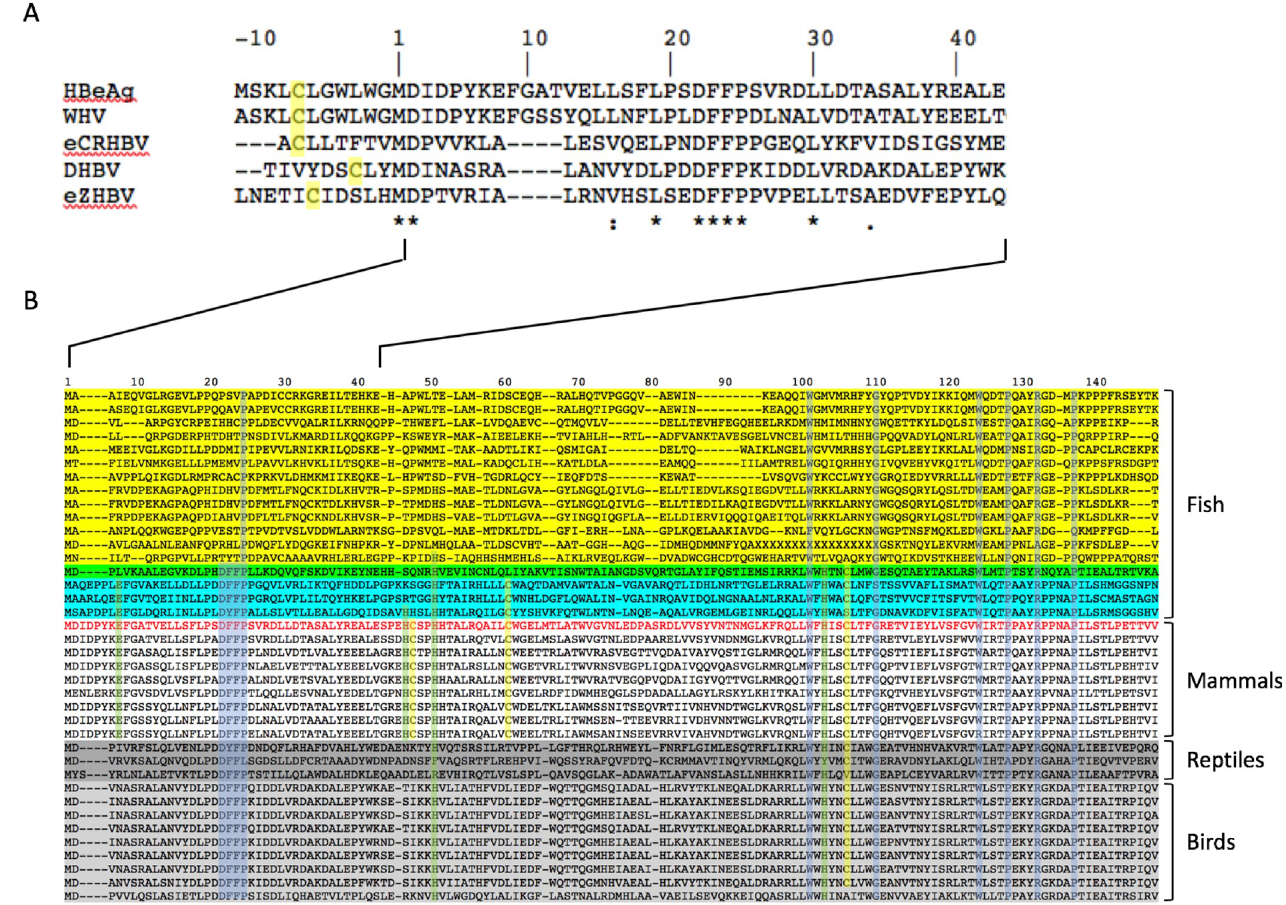
Fig 9. Multiple sequence alignment of core-antigen related proteins. (A) PreC/C ORF sequences. Shown are sequences for human (HBeAg), woodchuck (WHV), and duck (DHBV) viruses, and for zebra finch (eZHBV) and crocodile (eCRHBV) endogenized viral elements. For brevity, sequences are only shown up to the end of helix 2, in human core-antigen this is reside E43. (B) Core-antigen sequences. Sequence numbers correspond to human core-antigen residues 1–149. Viral clades are colored according to their host taxa: Nackednaviruses (yellow), Parahepadnaviruses (green), Metahepadnaviruses (cyan), Orthohepadnaviruses (none, except human ayw D, red), Herpetohepadnaviruses (dark gray), Avihepadnaviruses (light gray). There are seven residues (not counting M1) that are over 95% conserved in viruses from all four taxa of hosts (fish, mammals, reptiles, and birds). Shaded in the alignment are; the highly conserved residues (P25, W102, G111, W125, P129, R133, P138 and the DFFP motif at residues P22 –P25; light blue), the putative metal-binding motif (E8, H47, H51, and H104; light green), and the cysteine motif (C48, C61 and C107; light yellow). The sequences are adapted from previous phylogenetic analyses, as describe in text, by deleting insertions relative to the human